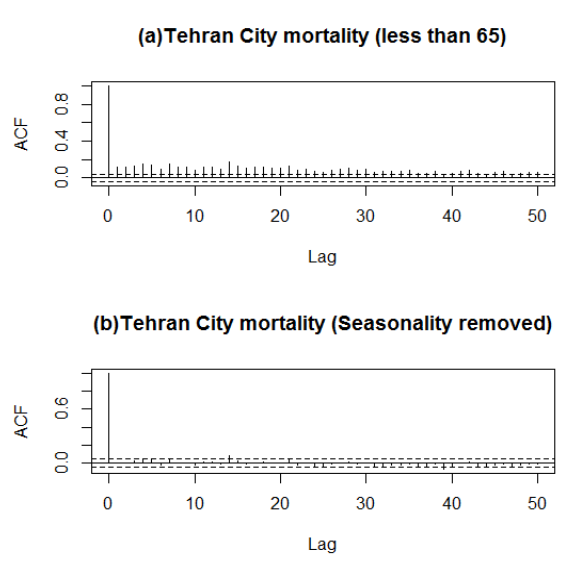
Figure 5. Autocorrelation functions for mortality data on Tehran for (a) raw data and (b) residuals after removing seasonality Simultaneous changes in mortality rate and PM 2.5 concentration in annual, seasonal, and weekly time scale are shown in figure